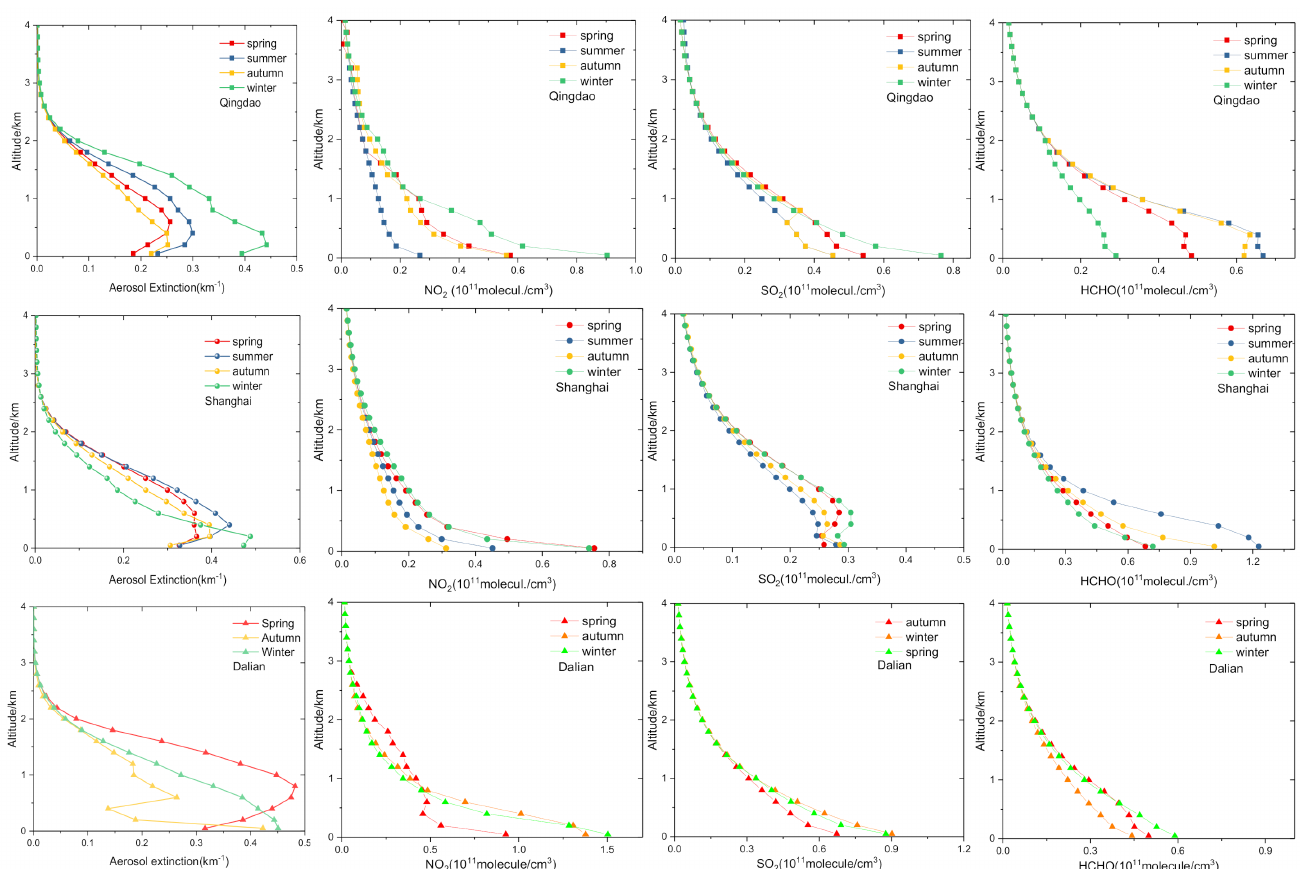
Figure 8. Seasonal mean profile of Qingdao, Shanghai, and Dalian